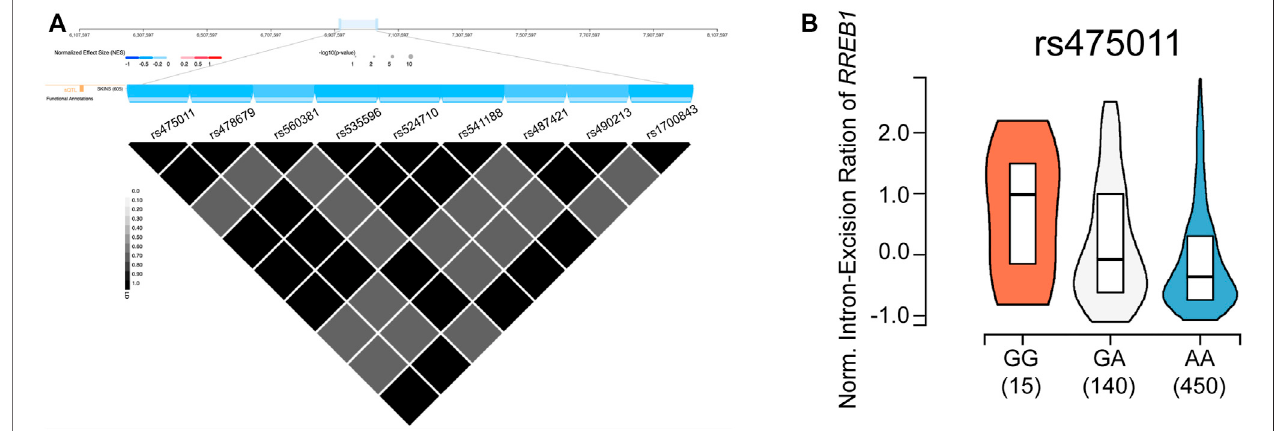
FIGURE4| rs475011actsasasplicingquantitativetraitlocus(sQTL)of RREB1 . (A) Upperlayer:physicalposition(basedonhumanreferencegenomehg38)ofthe SNP cluster containing rs475011. Middle (blue) layer: major alleles of the labeled SNPs are negatively associated with the intron excision ratio of RREB1 . Lower triangle plot: linkage disequilibrium (D ′ ) of SNPs in this cluster. Data were obtained from GTEx database. (B) Allele G of rs475011 is associated with an increased intron excision ratio of RREB1 . Y-axis represents the normalized intron excision ratio of RREB1 . The X-axis represents different genotypes of rs475011. Data were obtained from GTEx